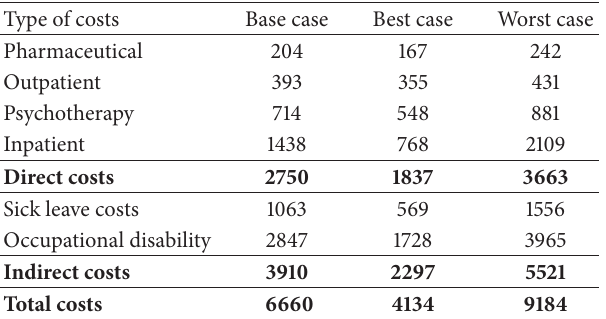
Table 2: Cost scenarios (in